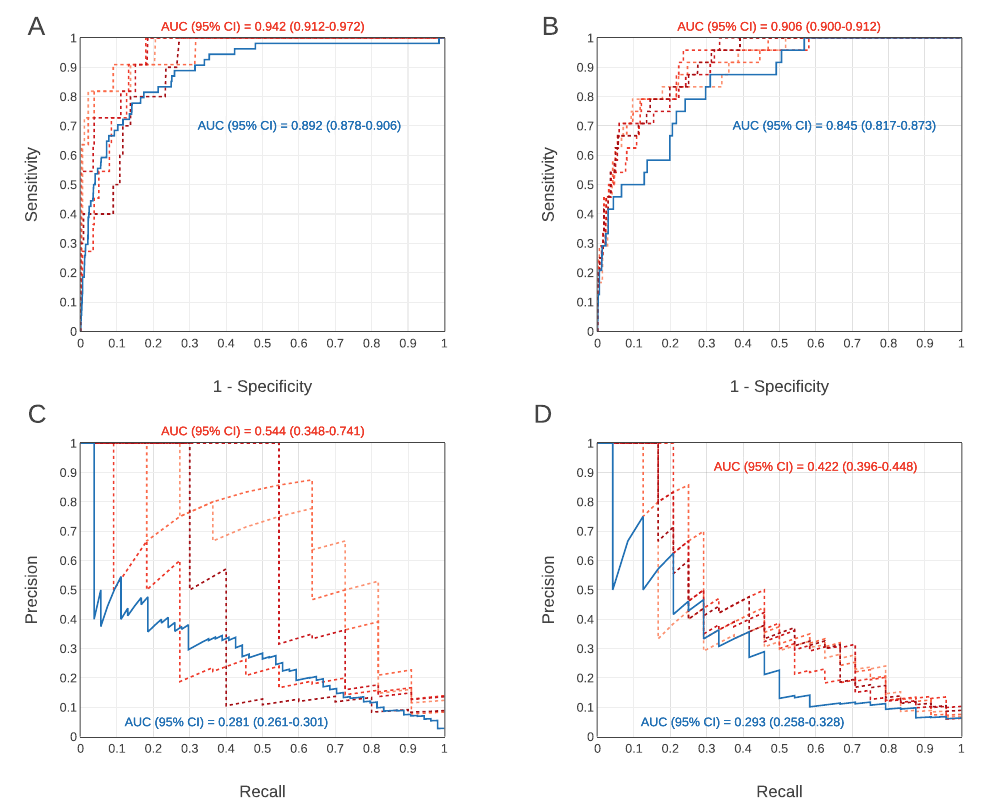
Figure 2. Evaluation of predictive performance of the random forest model and PIM 3. The receiver operating characteristic curves for mortality within 72 h of ICU admission from the derivation cohort are shown in ( A ), and the curves from the validation cohort are shown in ( B ). The precision-recall curve for mortality within 72 h of ICU admission from the derivation cohort are shown in ( C ), and the curves from the validation cohort are shown in ( D ). The red-based dotted curves are curves for each fold in the fivefold cross-validation process. AUC = the area under the curve, CI = confidence interval, PIM 3 = pediatric index of mortality